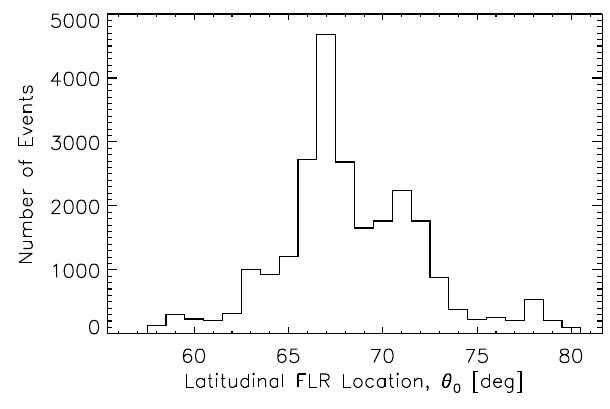
Fig. 6. Distribution of the latitudinal locations of the FLRs in ge- omagnetic coordinates. The distribution of the stations within the magnetometer array is reflected in the analysis. Binning used for the histogram: 1 ◦